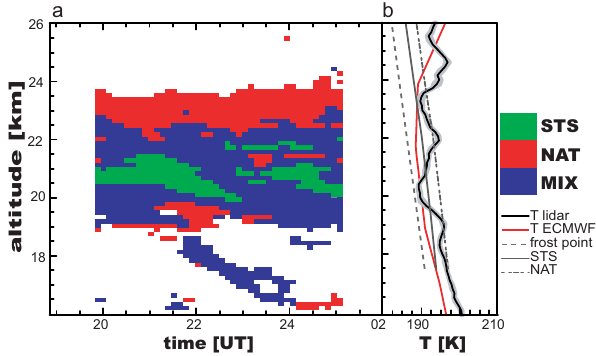
Fig. 5. (a) PSC classification of a measurement with the Esrange lidar between 19:48 and 01:23UT on 6 February 2011. (b) Temper- ature profile (black) and the error in the temperature (gray area) de- rived over the entire measurement period in comparison to ECMWF from 00:00UT on 7 February 2011. Gray lines indicate the forma- tion and existing temperatures for PSC of type: ice (dashed), STS (solid), and NAT